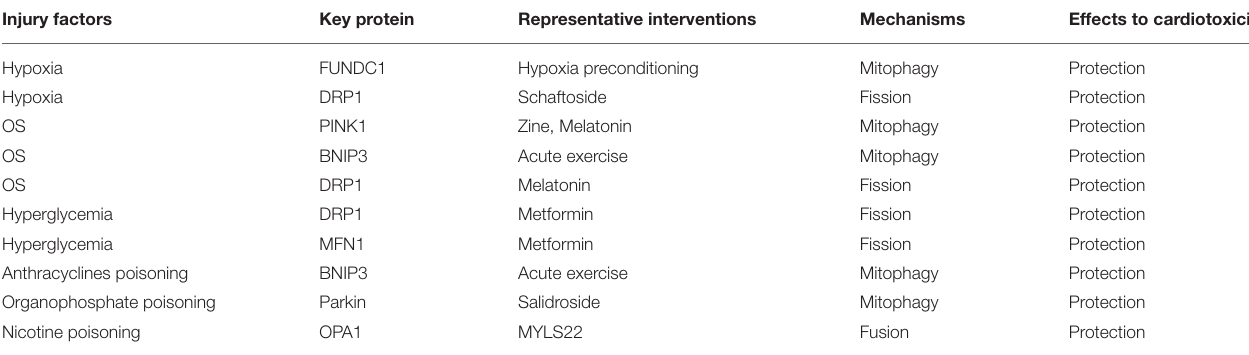
TABLE 1 | Therapeutic application of mitochondrial dynamics and